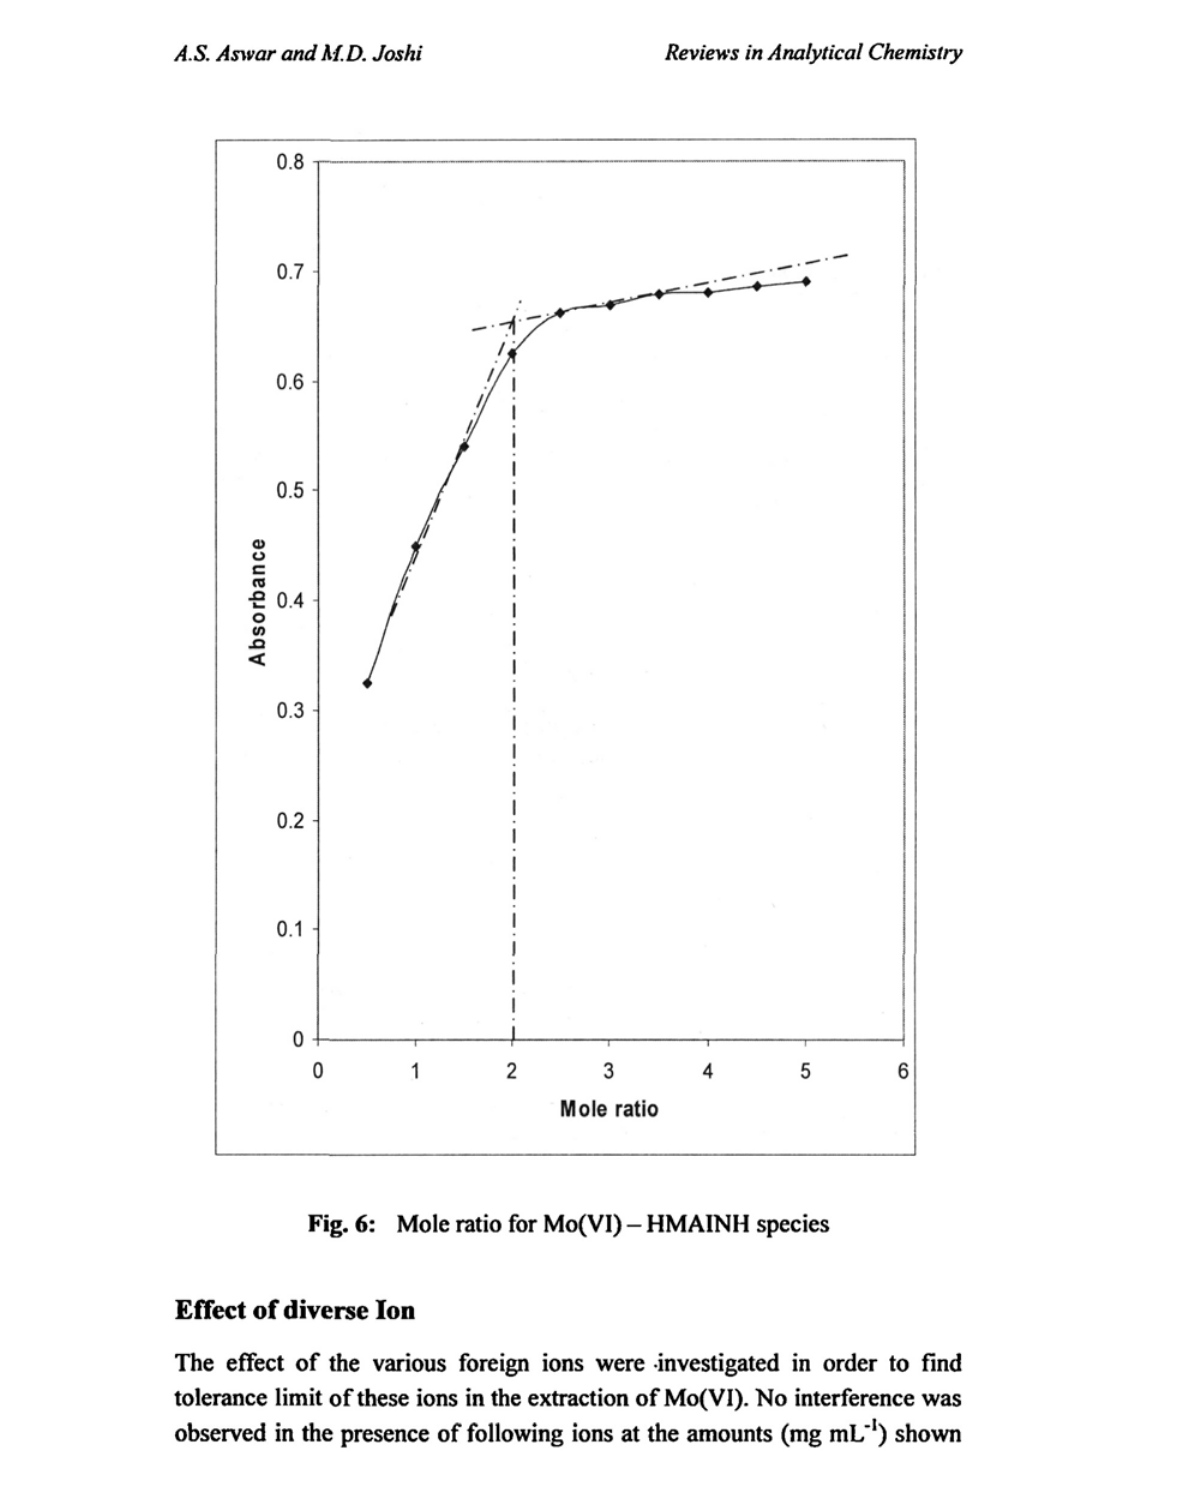
Fig. 6: Mole ratio for Mo(VI) - HMAINH